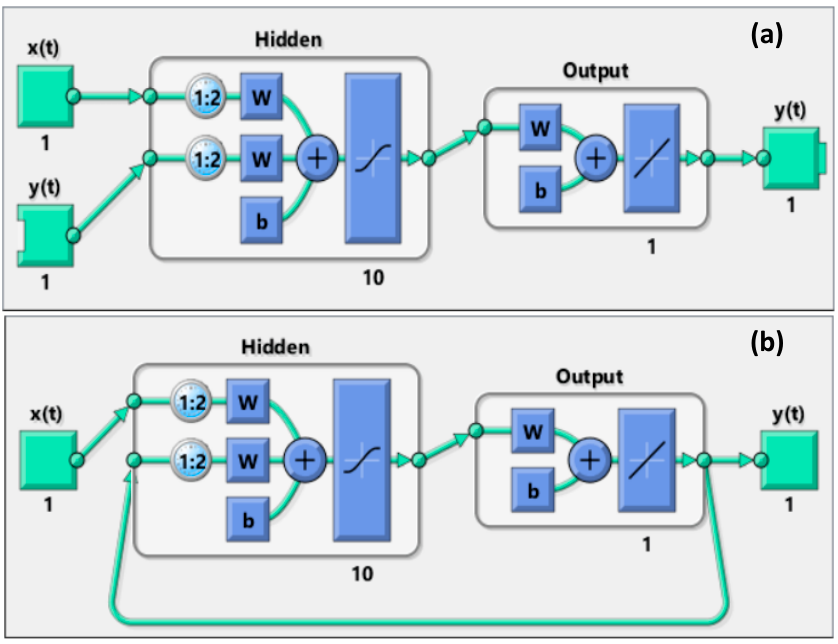
Figure 2. Matlab R2020a NARX-NN model architecture ( a ) Open Loop ( b ) Closed Loop [59].